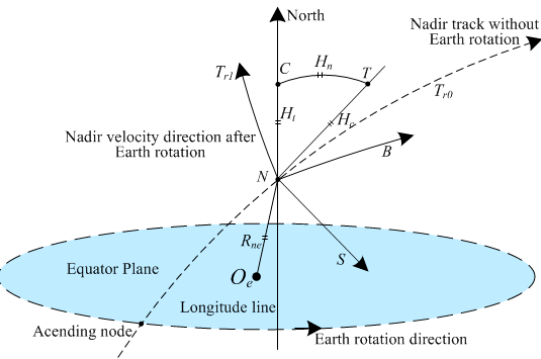
Figure 6. Geo-SAR staring mode spherical geometry model. where O e is the earth’s core, N is nadir, R ne is the earth radius at nadir, T is the scene center, NC represents meridians, C and T have the same latitude, and NB represents the intersection of the zero Doppler plane and the earth’s surface. NS represents the beam center projection on the ground without attitude controlling. NT r1 and NT r0 , respectively, represent the nadir track with and without the earth’s rotation. The deviation angle be- tween NT r0 and NC is α 1 , and that angle between NT r1 and NC is α 2 . They are presented as follows.